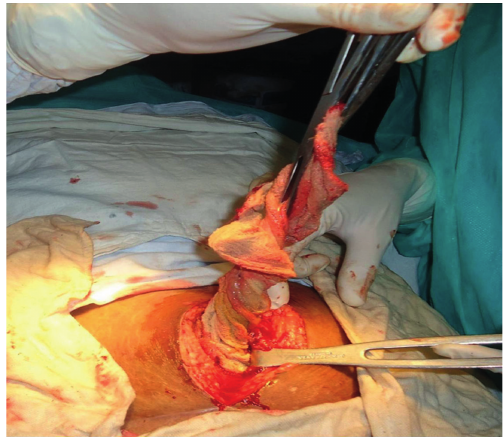
Figure 2: Intraoperative photograph showing the retained surgical sponge being removed.